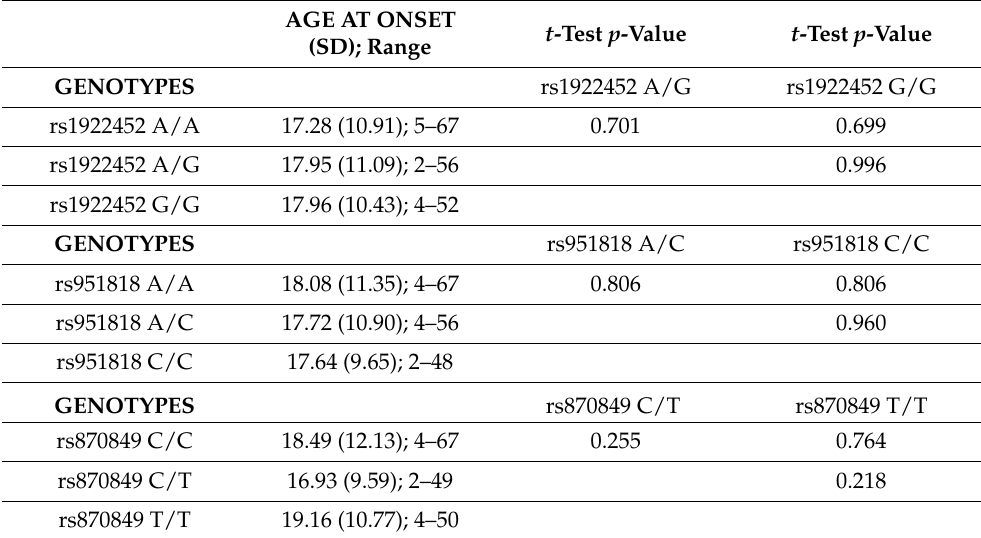
Table 2. Mean (SD) age at onset of migraine for the different